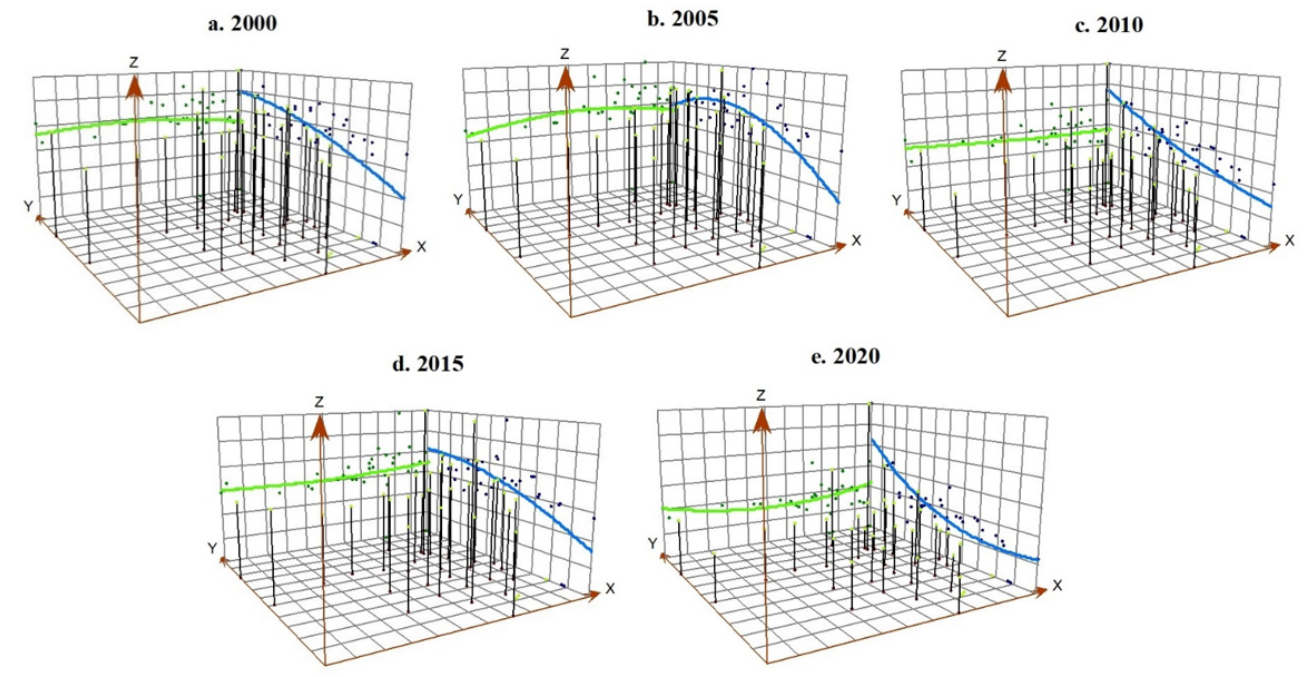
Figure 5. Trend analysis of GTCL in China during 2000–2020.